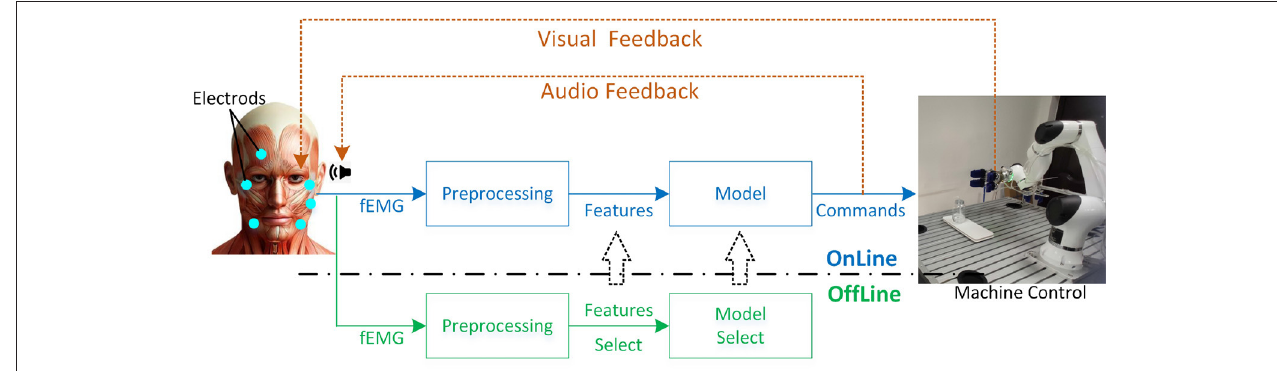
FIGURE 1 | The frame of the face-computer interface (FCI).